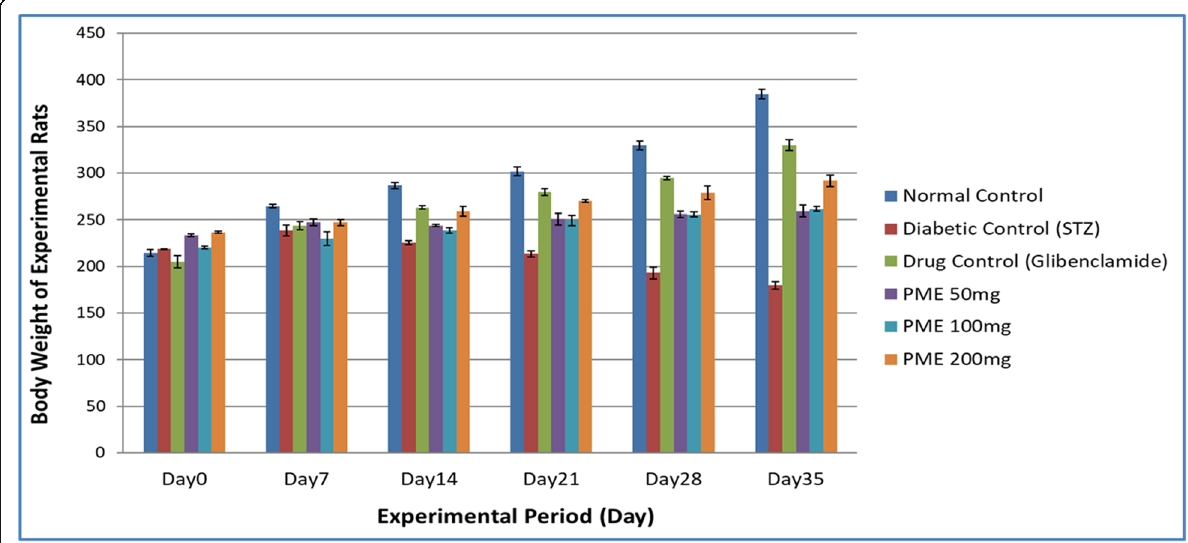
Fig. 3 The body weight of experimental rats after repeated oral administration of EEPM fruits ethanol extract for 35 days (5 weeks). Data are expressed as means ± SEM, n = 6 rats per group. * p < 0.5; * p < 0.01, when compared to starting